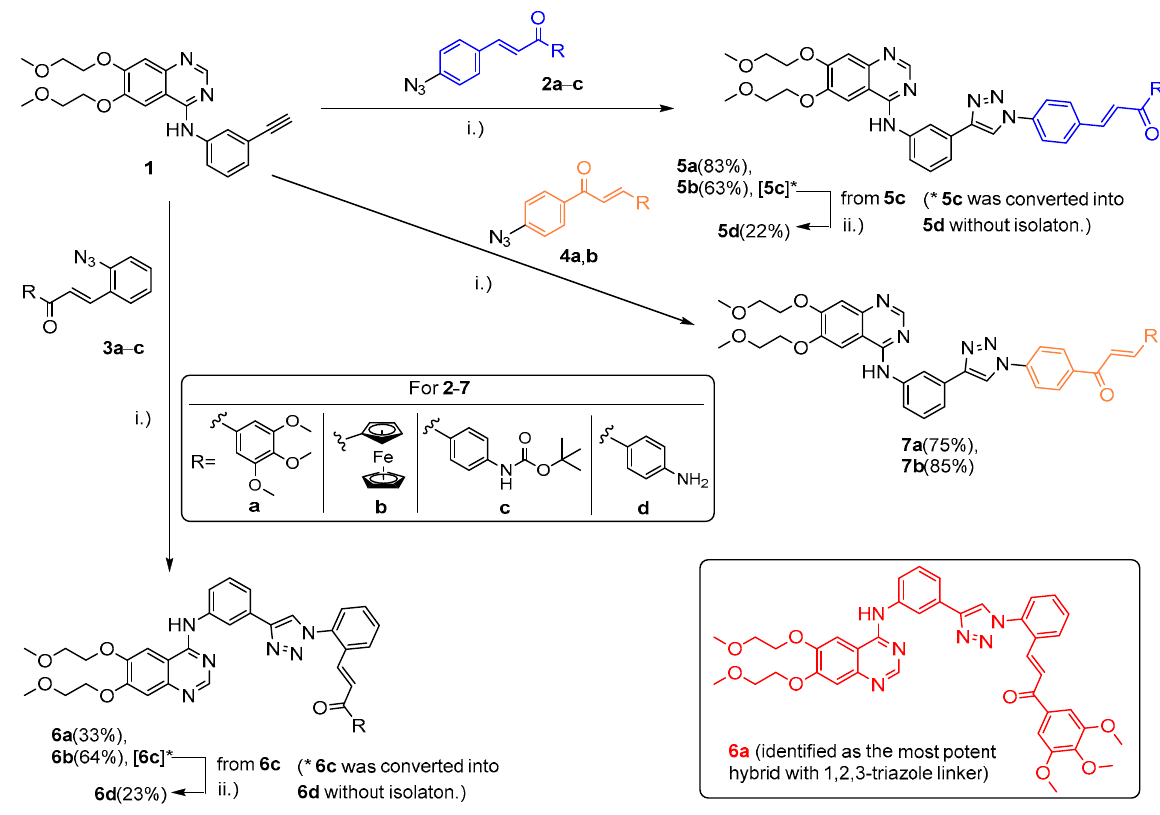
Scheme 1. Synthesis of the group of erlotinib–chalcone hybrids with 1,2,3-triazole